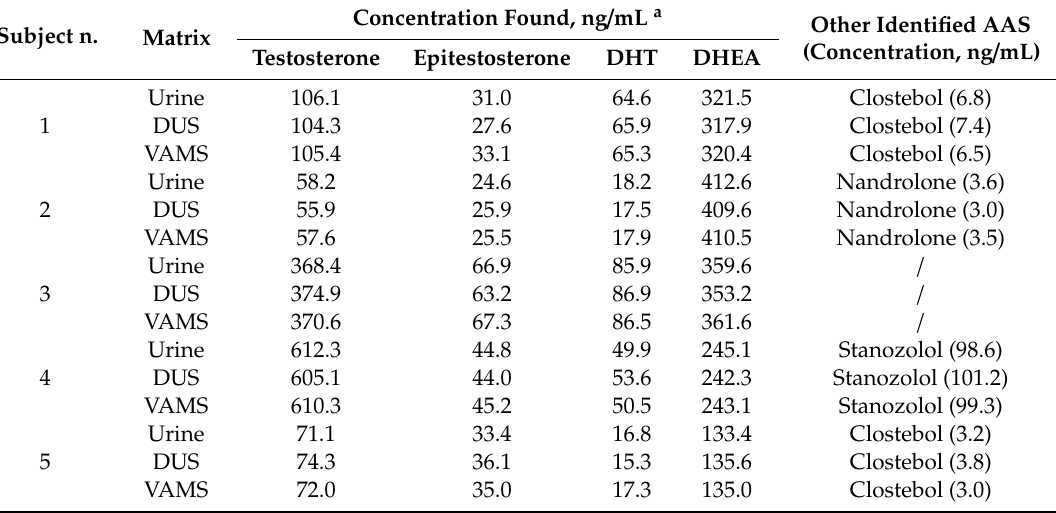
Table 7. Results of method application to real